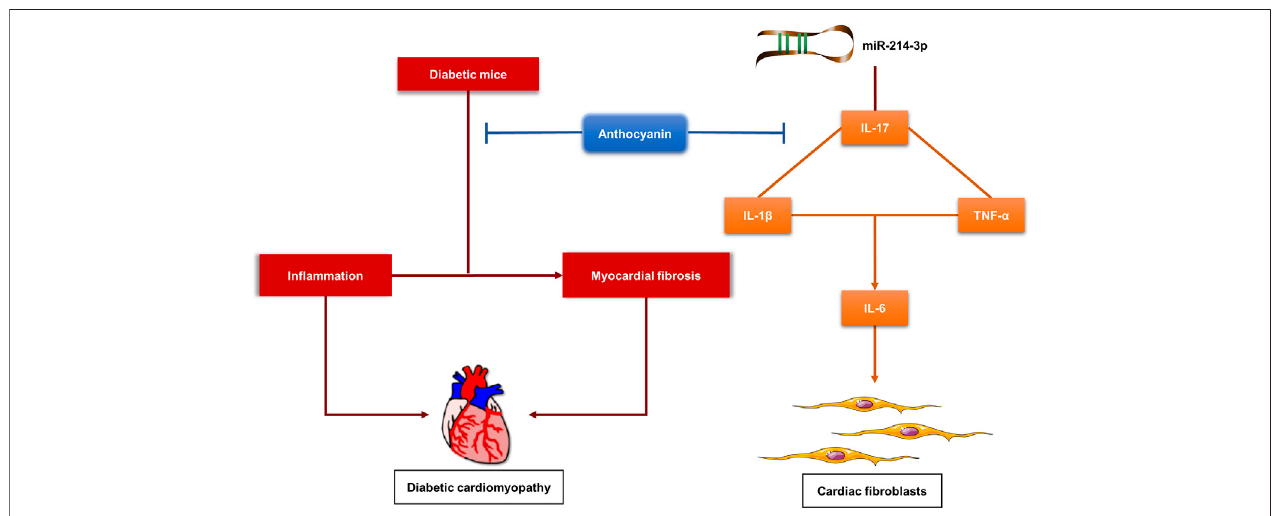
FIGURE6| Proposedmodelforthefunctionofanthocyanininalleviatingcardiacin fl ammationand fi brosisindiabeticmice,andregulatingin fl ammationand fi brosis via interaction between miR-214-3p and IL-17 in high-glucose-treated cardiac fi broblasts. HG, high glucose (25 mM), CFs, cardiac fi broblasts.